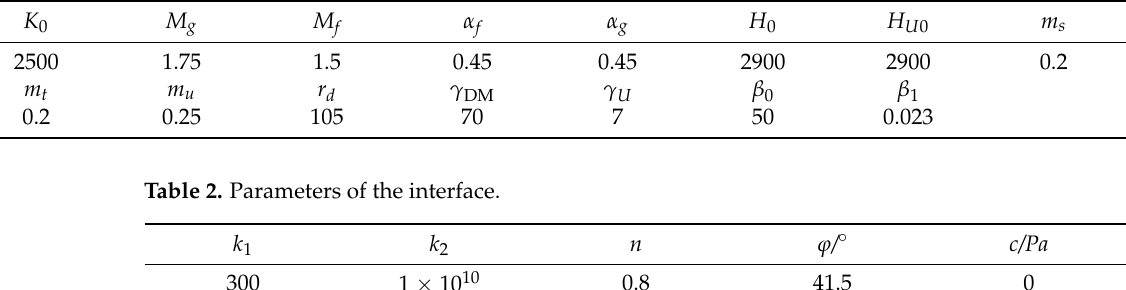
Table 1. Parameters of the rockfill.